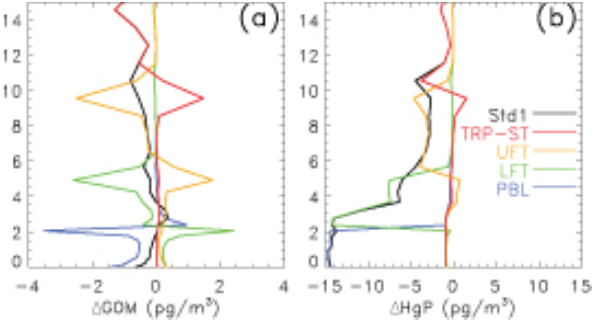
Fig. 7. Domain averaged perturbation of GOM (panel a ) and HgP (panel b ) at the end of the following simulations: PBL (blue), LFP (green), UFT (orange), TLS (red) and STD (black) sensitivity ex-